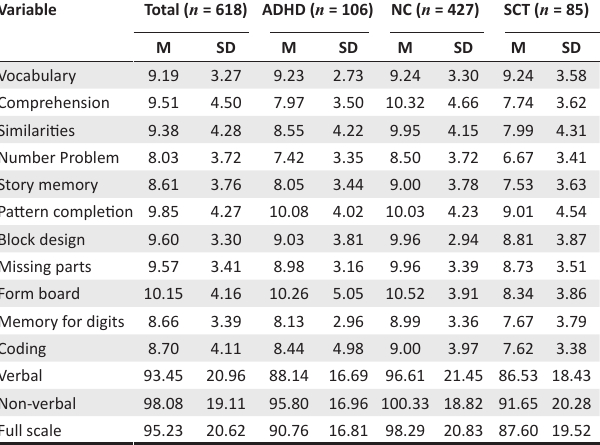
TABLE 6 : Mean and standard deviation scores of the different subtests for the three groups. Variable